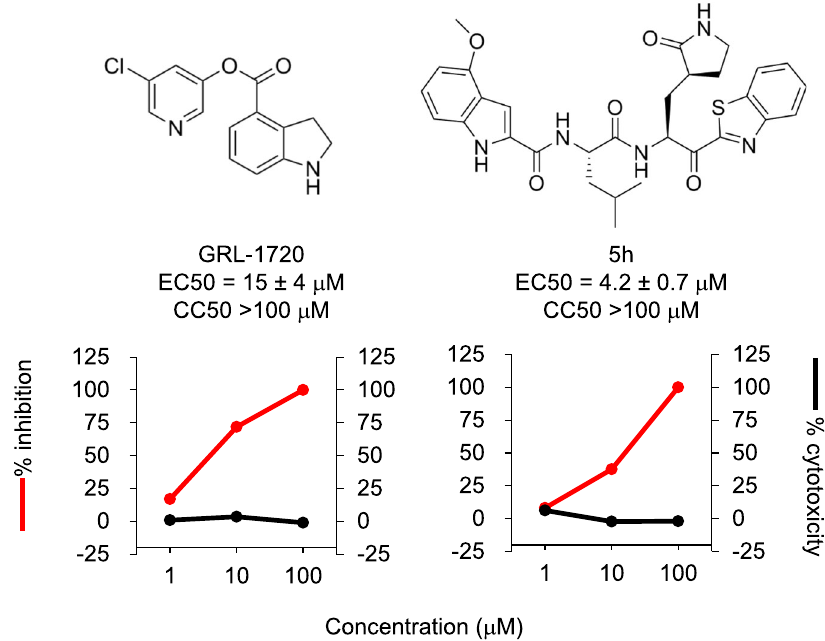
Fig. 2 The antiviral activity of GRL-1720 and compound 5h against SARS-CoV-2. VeroE6 cells were exposed to SARS-CoV WK-521 for 1 h, the virus was washed out, and the virus-exposed VeroE6 cells were cultured for 3 days. The viral copy numbers in the culture supernatants were determined using RT-qPCR. Red and black lines indicate reduction of viral copy numbers and cytotoxicity, respectively. Each compound was tested upon at least three different occasions. The data in Fig. 2 are representative ones. Both graphs were generated with Microsoft Excel. EC 50 values shown denote means ± 1 S.D. All compounds shown in Fig. 2 were tested and compared in one assay performed in duplicate ( n = 2). Source data are provided as a Source Data fi